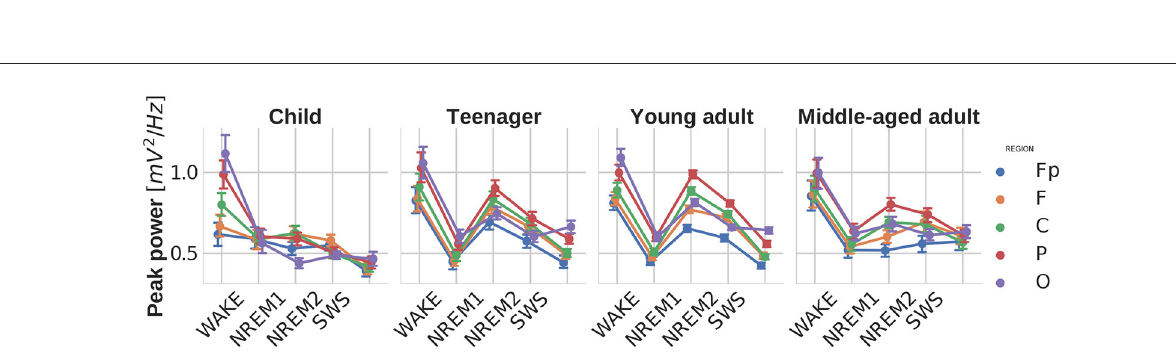
FIGURE5 Power of the largest spectral peak as function of sleep stage, brain region, and age group. Note the high peak power in wakefulness and NREM2 sleep, known to be characterized by prominent alpha and sleep spindle oscillations, respectively. In addition, peak power is lower in children and in middle aged adults, as compared to teenagers and young adults. This pattern coheres with the ontogeny of sleep spindle oscillation in humans. Vertical bars denote 95% confidence